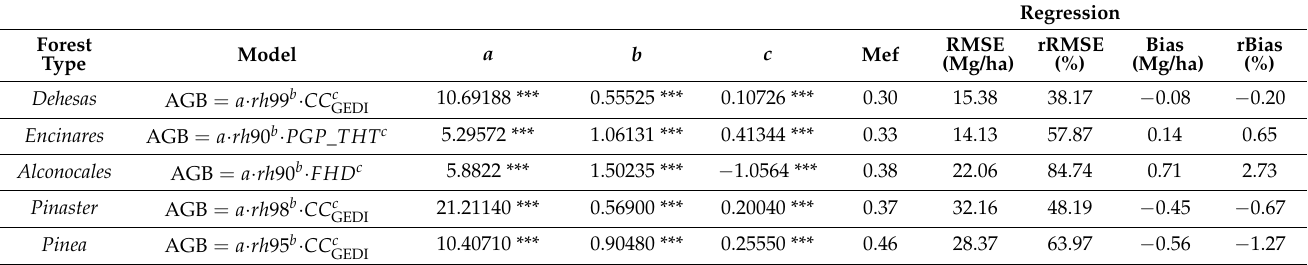
Table 6. Assessment of each GEDI-based AGB model dataset calculated with respect to the reference ALS-based AGB model estimates at the level of GEDI